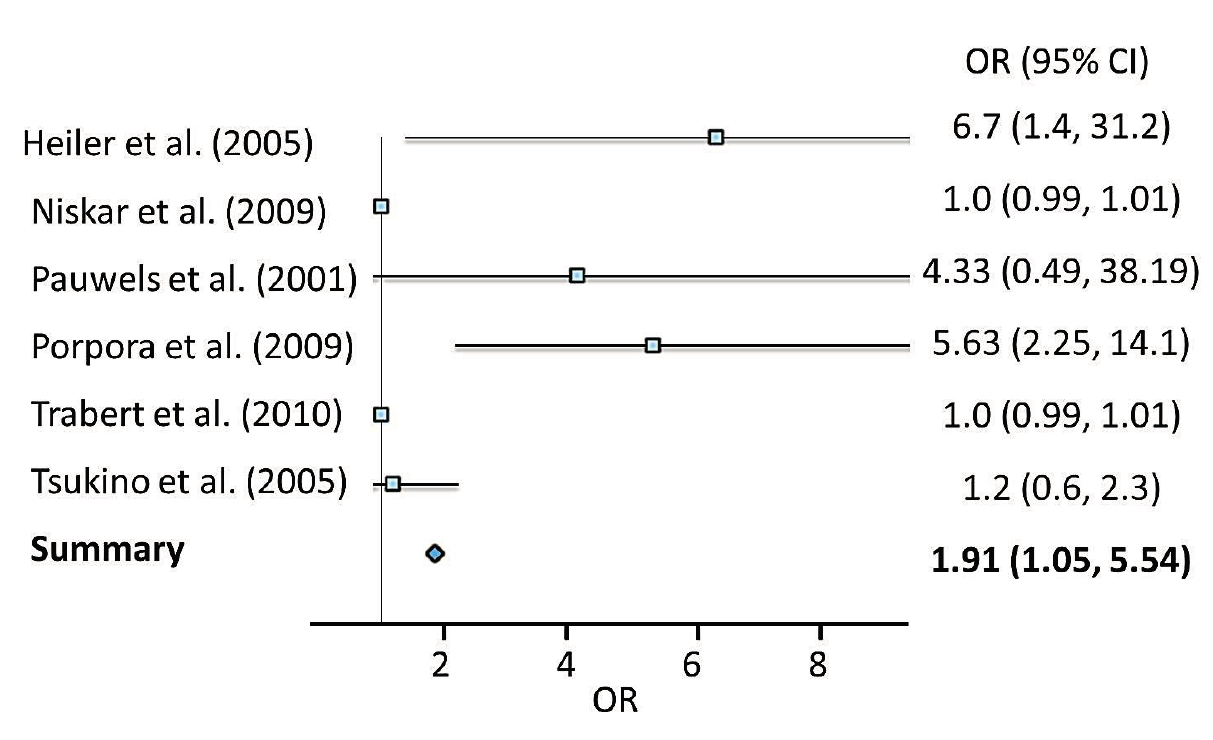
Figure 4. Forest plot of epidemiological studies of the associations between exposure to PCBs and risk of